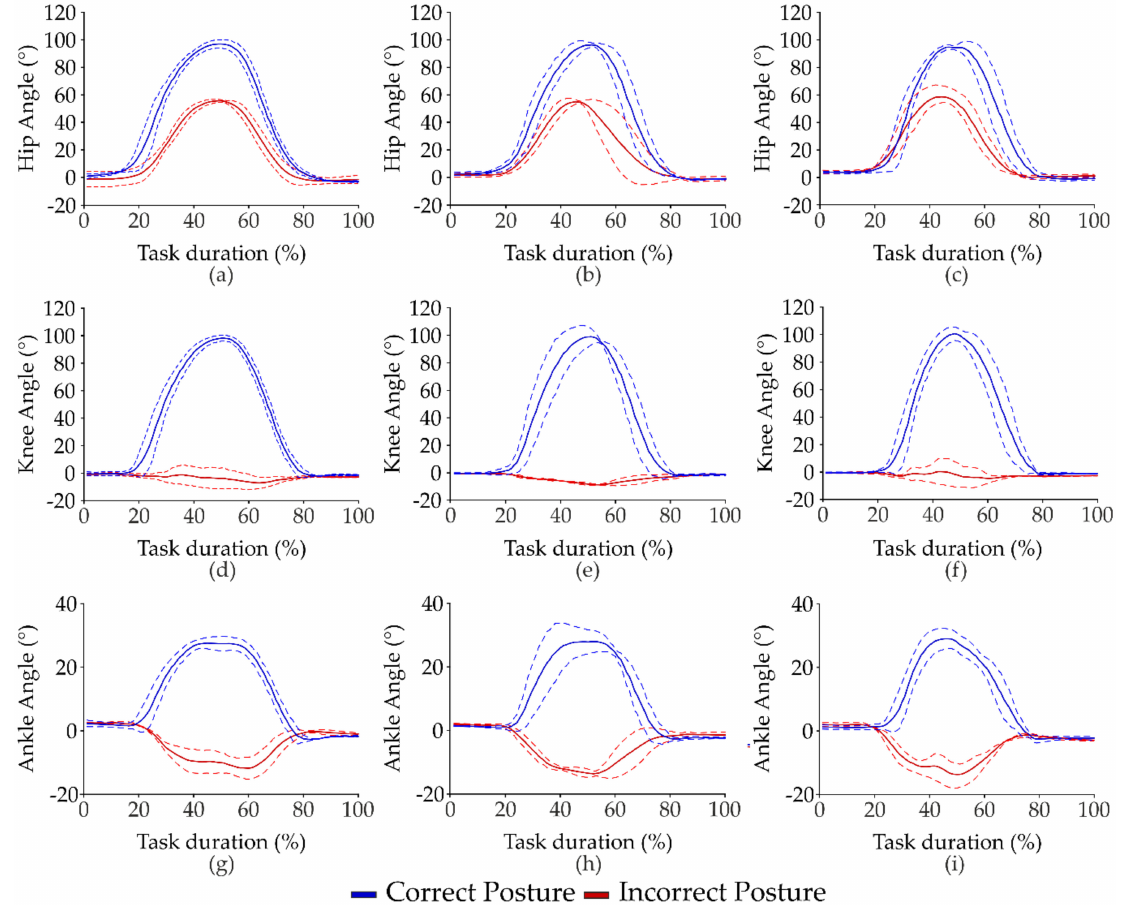
Figure 3. Mean (solid line) and standard deviation (dashed line) values of the range excursion of the right lower limb joint angles in the sagittal plane with respect to the task duration of a subject performing the CLL and ILL tasks with 1 kg ( a , d , g ), 2kg ( b , e , h ) and 5 kg ( c , f , i ) loads. Table 3. Overall accuracy (Acc), specificity (true negative rate (TNR)), sensitivity / recall (true positive rate (TPR)) and precision (positive predictive value (PPV)) values of the posture recognition when using the four di ff erent kernel functions considering the trunk–lower limb (T-Ll) and upper body (UpB) datasets in the LL